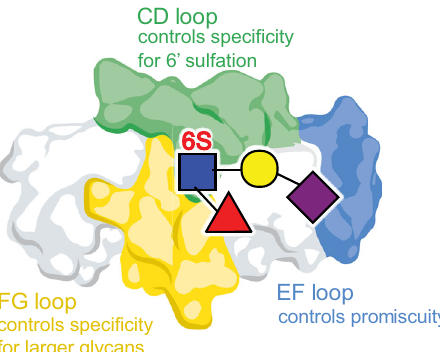
Fig. 10 Model for how SLBRs control sialoglycan selectivity. The glycan- binding pocket of SLBRs is organized above a Φ TRX sequence motif on the F-strand of the V-set Ig fold that interacts with sialic acid. Three variable loops surround this sialoglycan binding pocket and affect selectivity. In the broadly-selective SLBRs, fl exibility of the EF loop correlates with breadth of selectivity. The CD loop controls speci fi city for 6- O- sulfated glycans, and the FG loop may control whether the SLBR prefers trisaccharides versus larger glycans. Tetrasaccharides containing α 1,3-fucosylation were tested here, but past studies of SLBR SrpA identify that a small FG loop correlates with the ability to accommodate larger glycans 23